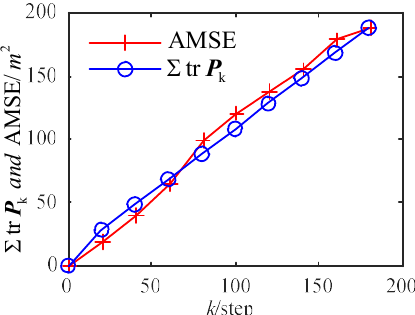
Figure 3. AMSE of ET-KF algorithm and tr